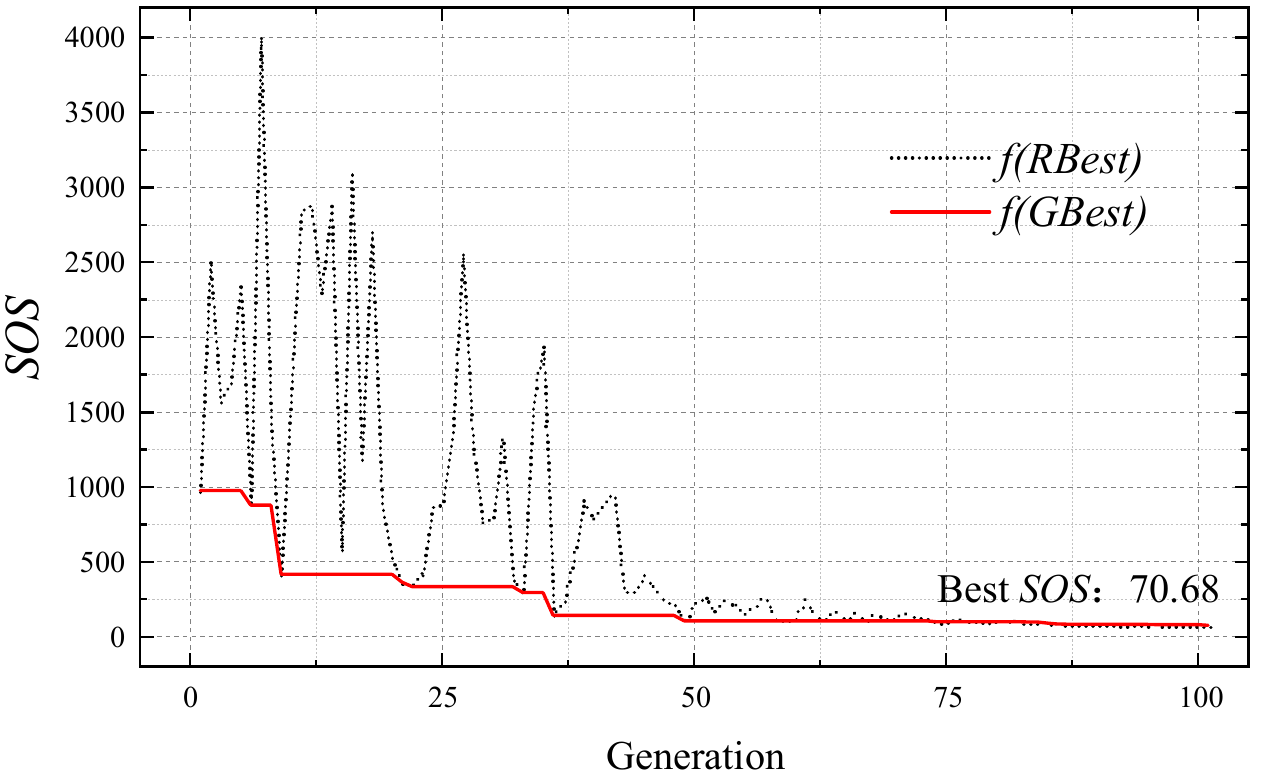
Table 4. Comparison of parameter optimization